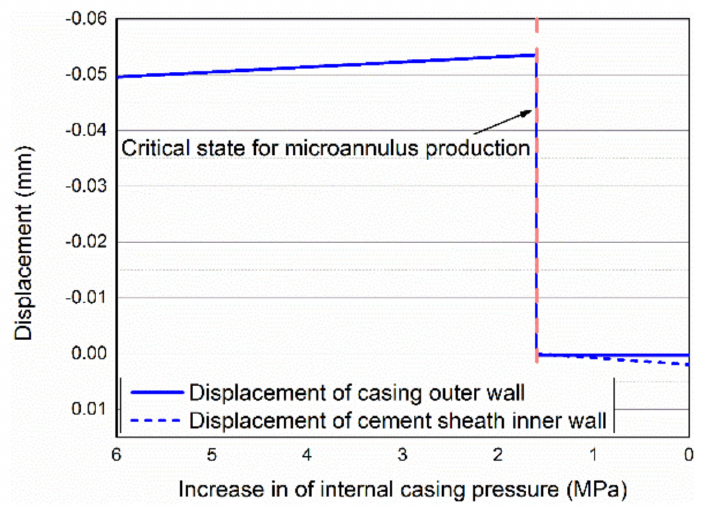
Figure 12. Displacement and micro annulus of casing–cement sheath interface.